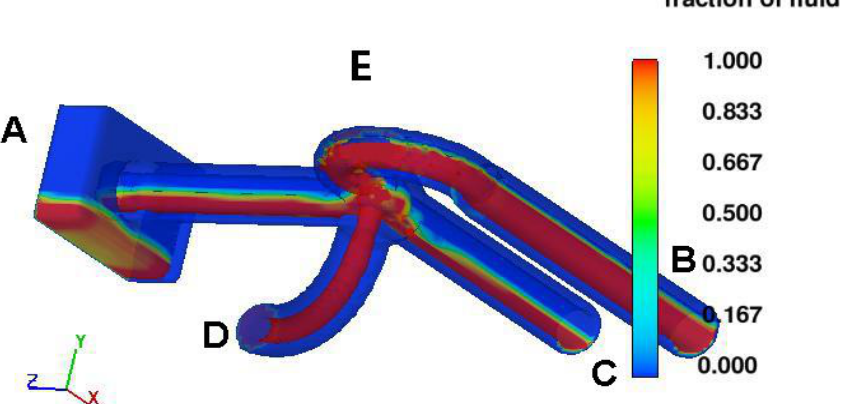
Figure 6. Establishment of steady-state flow conditions in pipelines. Figure from [2], pp. 291–292.